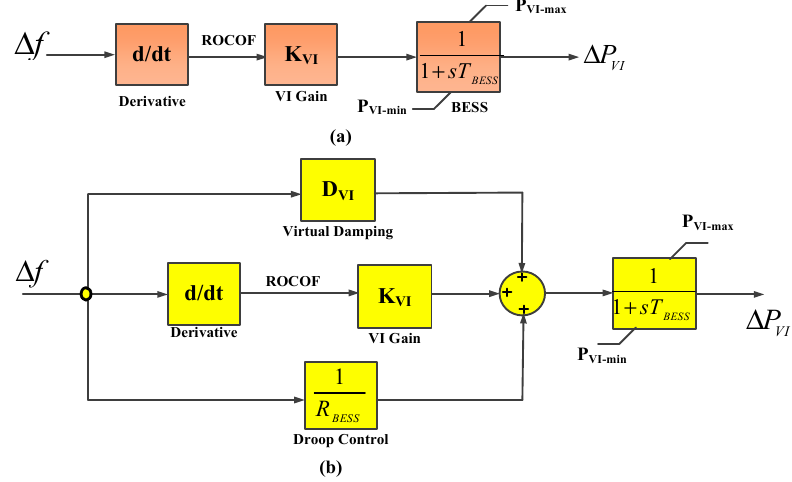
Figure 3. The dynamic structures of the VIC. ( a ) Conventional VIC. ( b ) Proposed